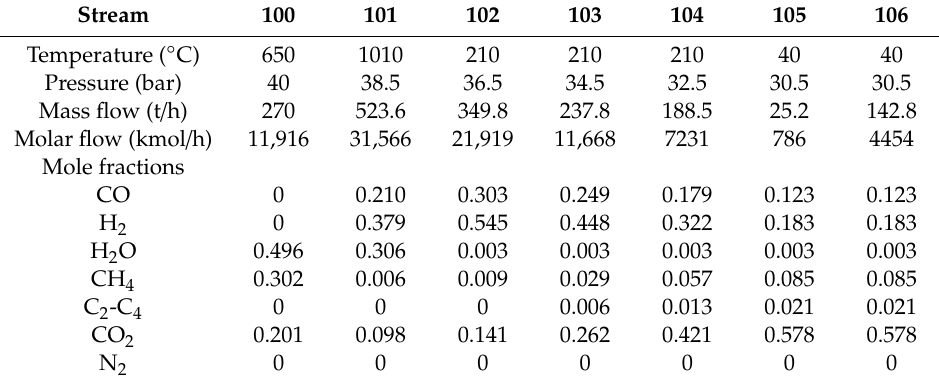
Table 3. Important stream information in Figure 9 with bold tag numbers.